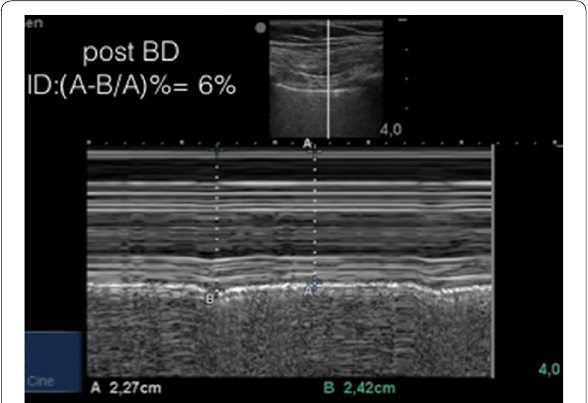
Fig. 2 M-mode re-evaluation of the pleural displacement and index calculation at 17 min of treatment, showing improvement with treatment